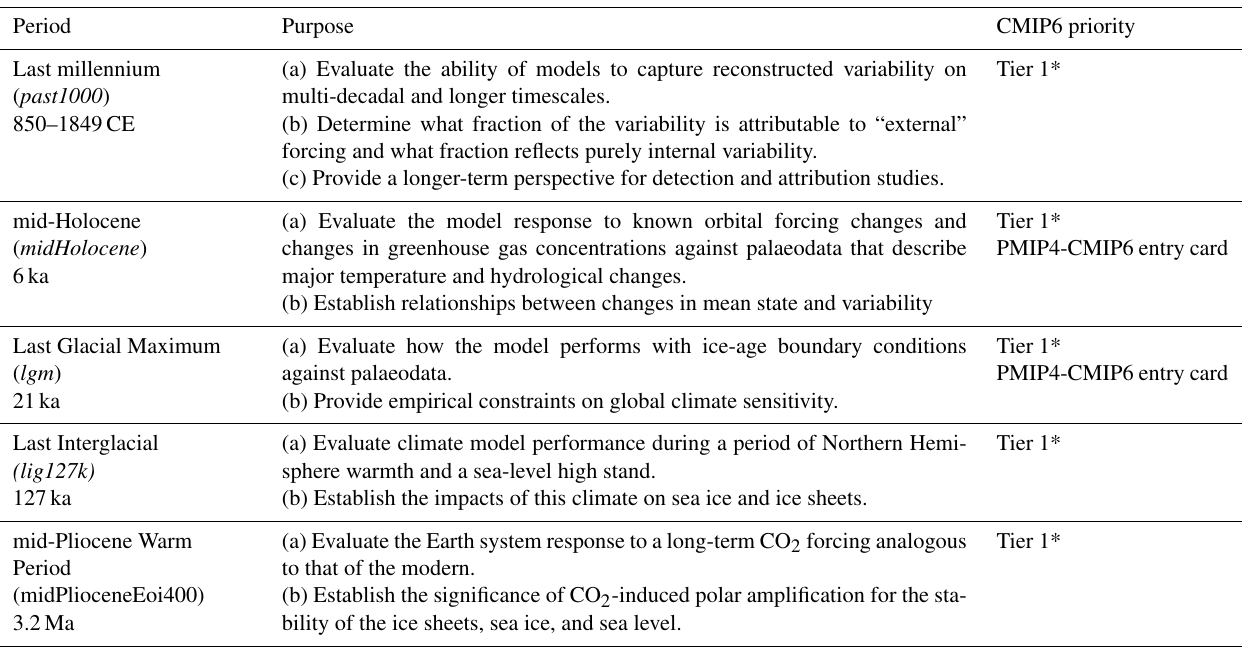
Table 1. Characteristics, purpose, and CMIP6 priority of the five PMIP4-CMIP6 experiments. All experiments can be run independently. Calendar ages are expressed in Common Era (CE) and geological ages are expressed in thousand years (ka) or million years (Ma) before present (BP), with present defined as